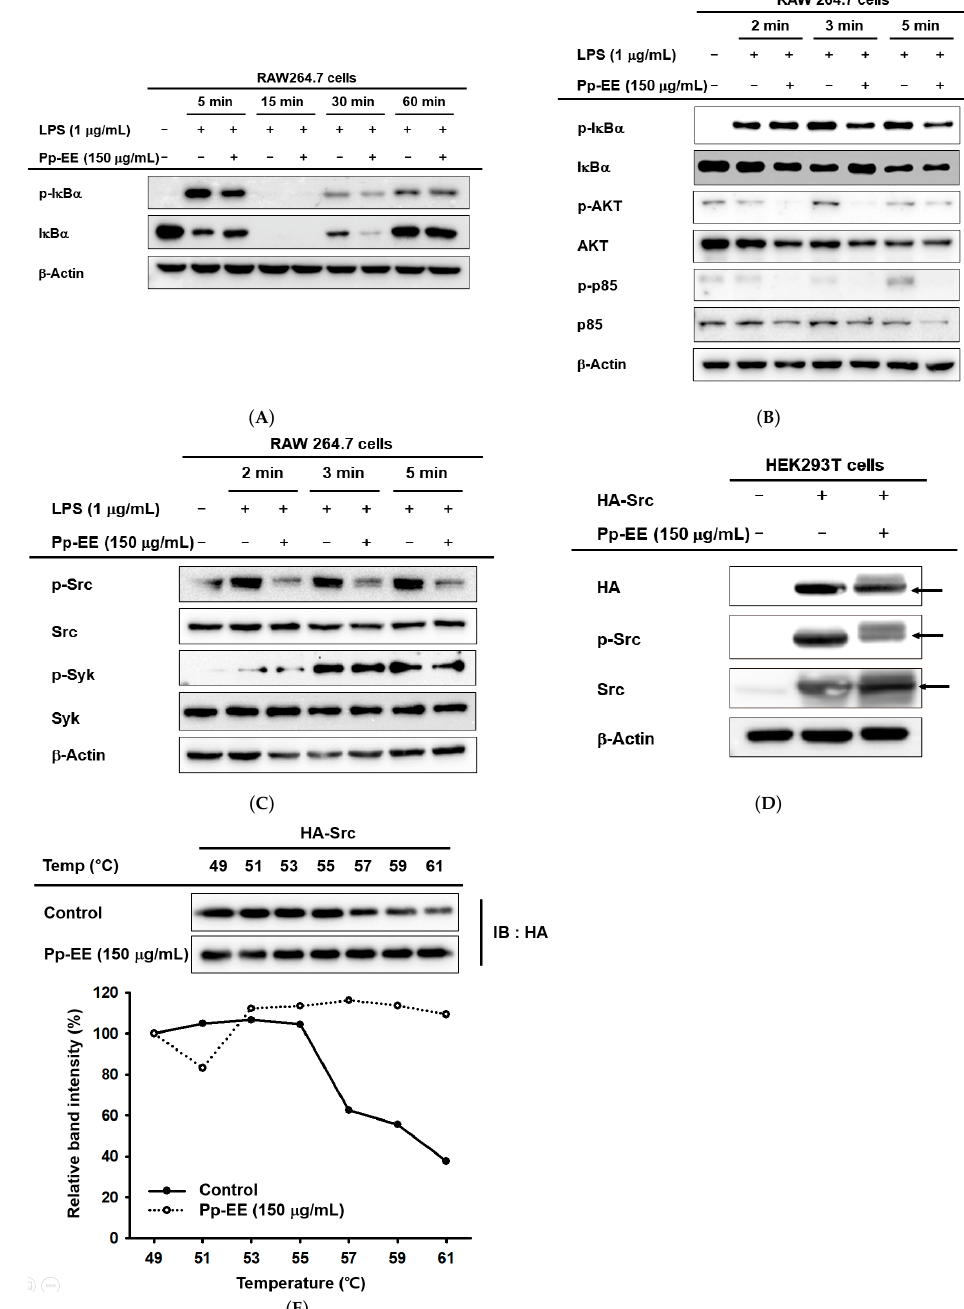
Figure 3. Pp-EE targeting Src of the NF- κ B signal pathway. ( A – C ) RAW264.7 cells were pretreated with Pp-EE (150 μ g/mL) for 30 min and induced an inflammatory response by LPS (1 μ g/mL) at different times. Phosphorylation level and total level of I κ B α , AKT, p85, Src, and Syk were detected by Western blot. ( D ) Verification in HEK293T cells with HA-Src over-expression. Total and phospho-forms of Src and β -actin were examined by Western blotting. ( E ) Stabilizing effects of Src protein through interaction with Pp-EE were confirmed by CETSA. Western blotting was performed on the cell lysate, and the calculation of band intensity of Src was carried out through Image J. − : no treatment and +: treatment.